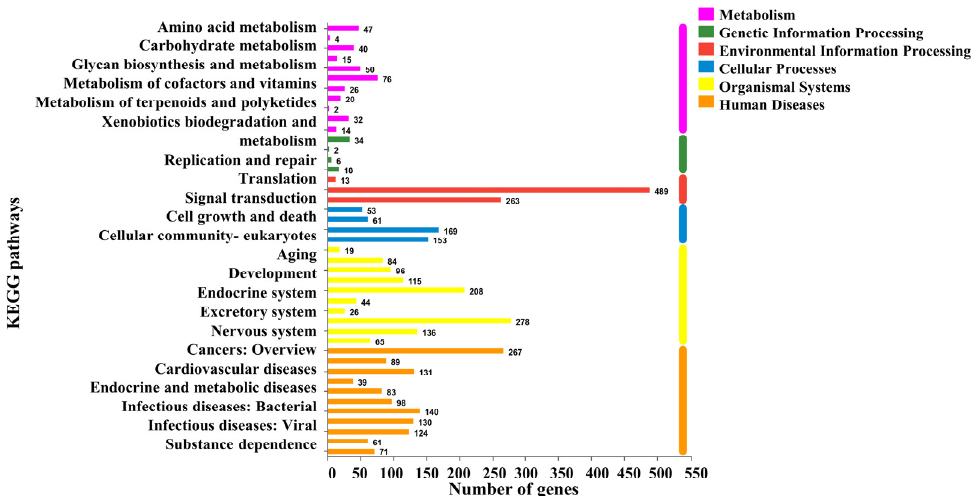
Figure 3. Changes in intestinal functions between Group HFD and Group FPD. HFD, Group HFD, rats were fed D12492 during the establishment of the obesity model and then fed AIN-93M; FPD, Group FPD, rats were fed D12492 during the establishment of the obesity model and then fed an FP-containing diet.